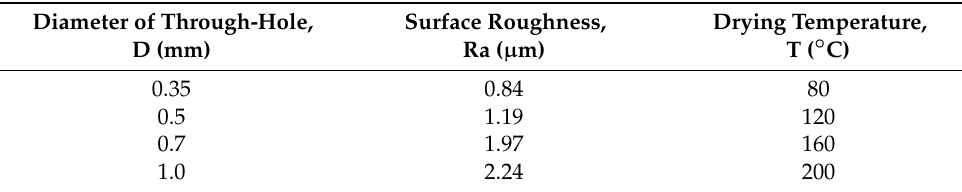
Table 1. Factors of the orthogonal experiment.